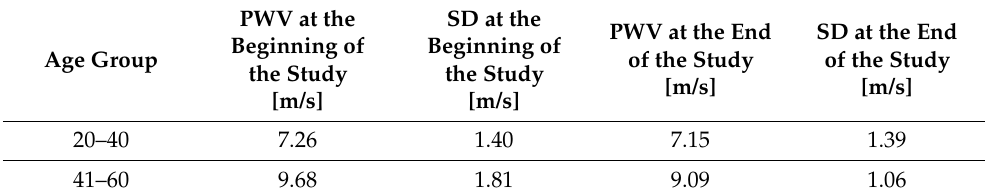
Table 5. The PWV results by age group.